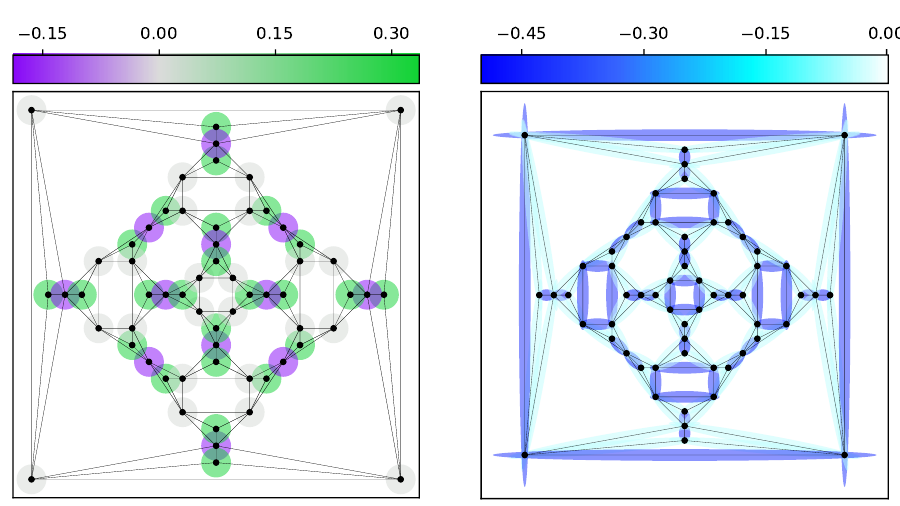
Figure 7: Ground-state properties in the sector S magnetization plateau. The left and right panel show 〈 S spin-spin correlations, respectively. Note the appearance of localized singlet states, 〈 S 〉 ≈ 0, with strong antiferromagnetic correlations (the grey sites along the square i faces in the left picture).